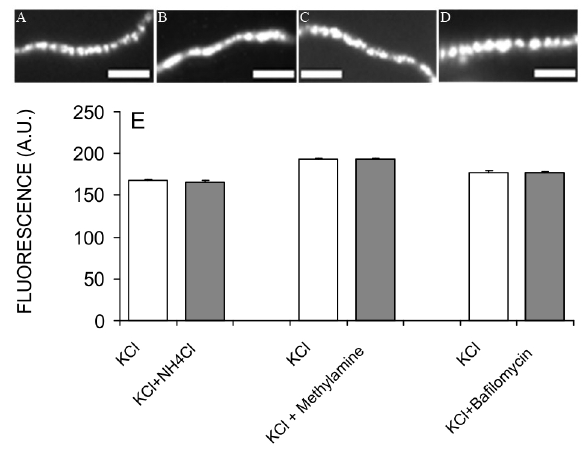
methylamine 10 м ( C ) and KCl 60 mм + bafilomycin 1 µм ( D ). Scale Bar for all images = 10 µm. Quantification of FM1-43 staining after 30 min of stimulation with KCl, KCl + NH4Cl, KCl + methylamine and KCl + bafilomycin, respectively ( E ).